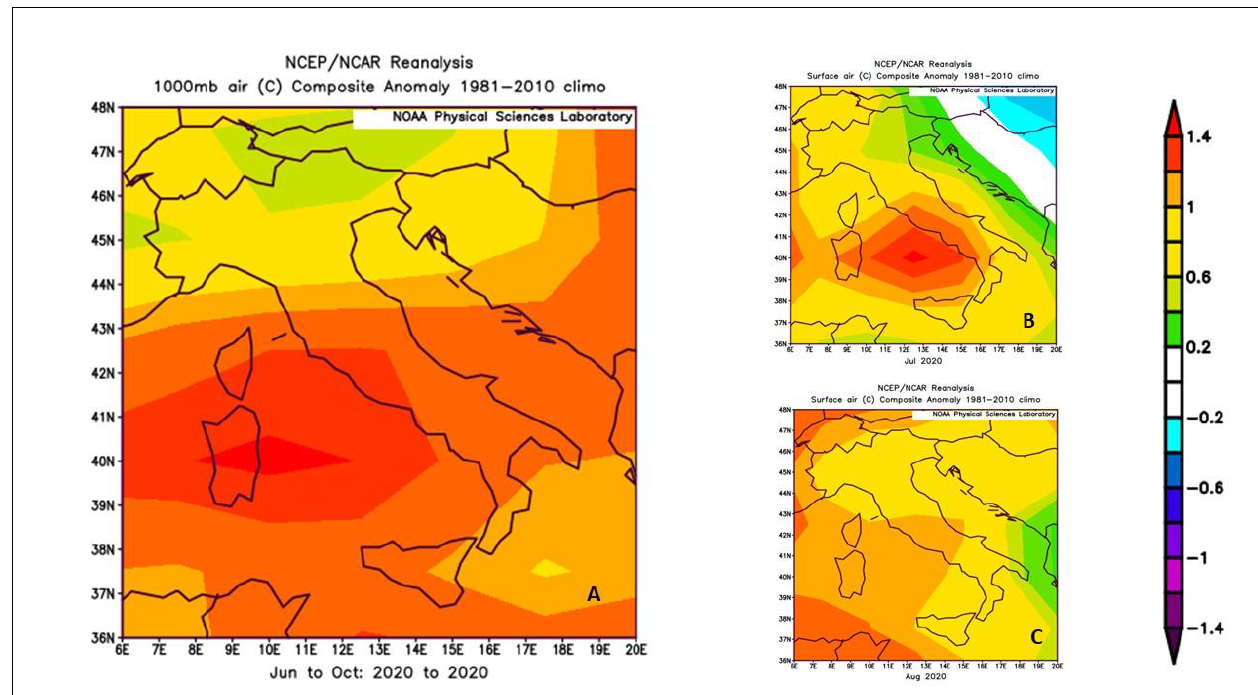
Fig 1. Air Temperatures anomalies in Italy during the period June-October 2020 (A), July (B) and August 2020 Figure 1. Air temperatures anomalies in Italy during the period June–October 2020 ( A ), July ( B ), and August 2020 ( C ) compared to the reference period 1981–2010. Data obtained from https://psl.noaa. (C) compared to the reference period 1981-2010. Data obtained from https://psl.noaa.gov/cgi- gov/cgi-bin/data/composites/printpage.pl, accessed on 27 January bin/data/composites/printpage.pl, accessed on 27 January 2022.